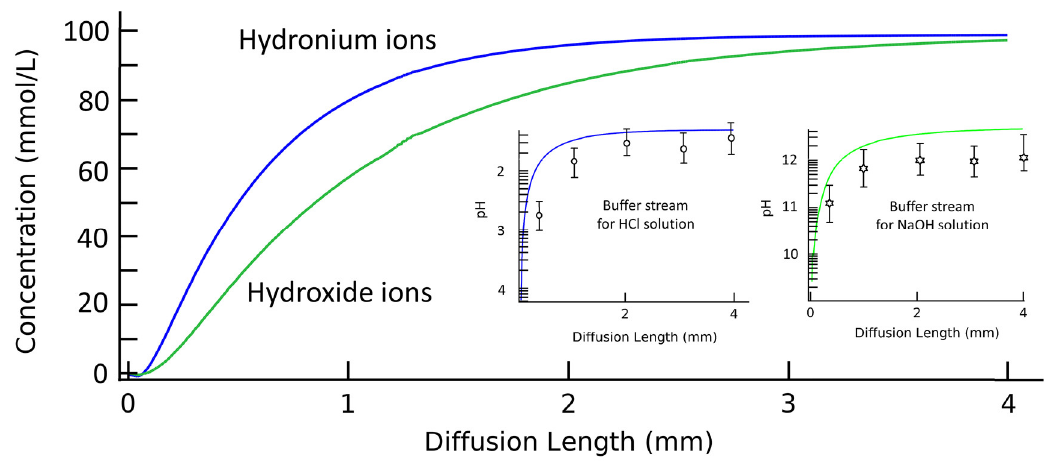
Figure 4. Simulation and experimental results of spatial ionic concentration and the corresponding pH gradient of the buffer stream along the diffusion channel. The simulation results are averaged from the concentration profile of the buffer stream cross-sections along the diffusion channel. Inserts are corresponding pH gradients of buffer streams along the diffusion channel when solution streams are HCl or NaOH solutions, respectively. The length of the diffusion channel is changed from 0.5 mm to 4 mm while the pH values of buffer streams are tested by a pH meter. The experimental results are demonstrated as circle and star dots in inserts. The width of diffusion channel is 100 µ m. The volumetric flow rates for two laminar streams are 1 µ L · min − 1 . The presented experimental results are averaged from five tests.